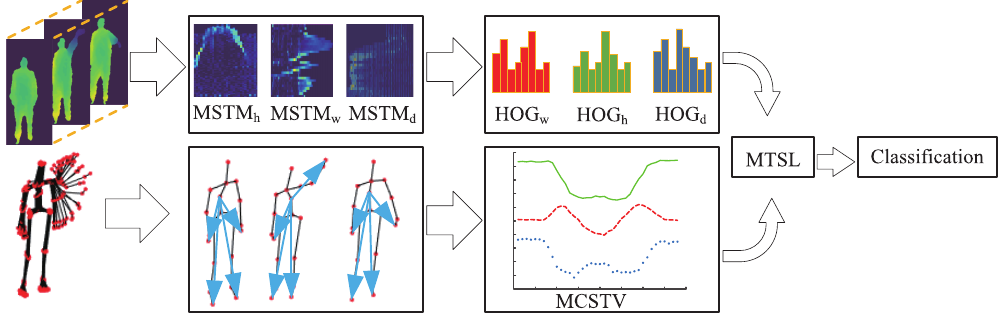
Figure 1. Workflow illustration of our